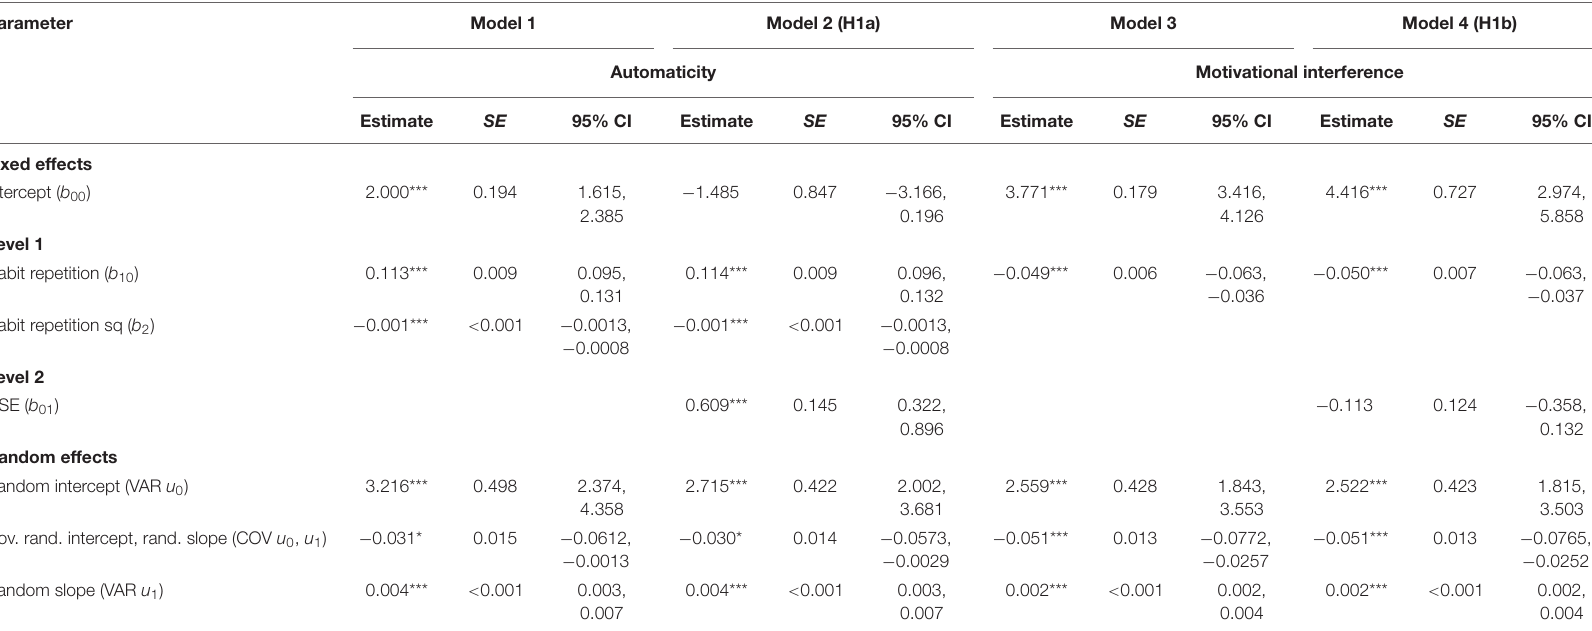
TABLE 1 | Multilevel regressions of automaticity and motivational interference on general self-efficacy based on controlled study data (Stojanovic et al.,